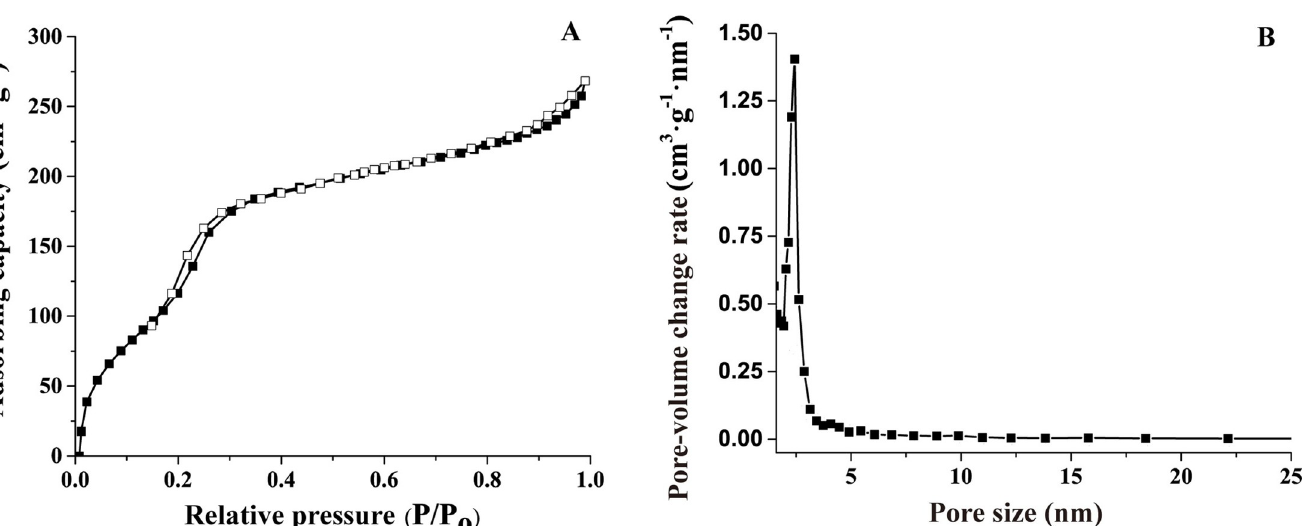
PLOS ONE | https://doi.org/10.1371/journal.pone.0238837 September 10,